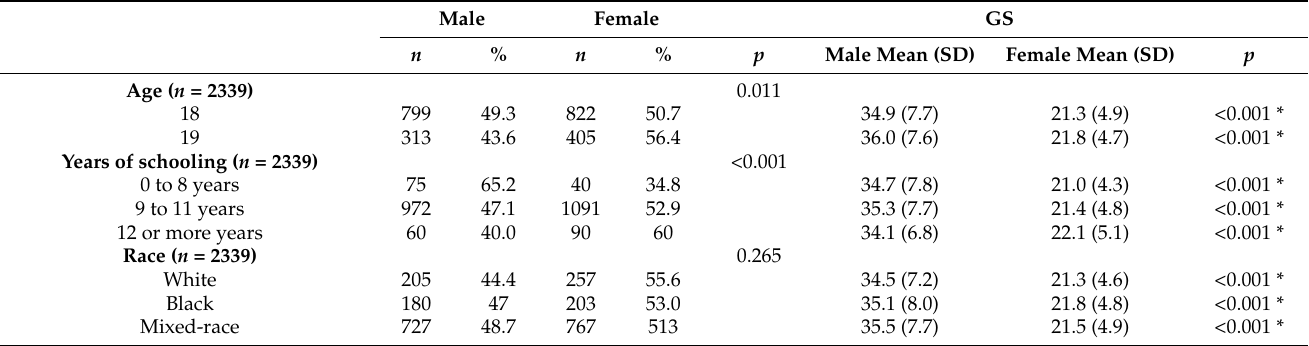
Table 1. Sample characterization according to demographic, socioeconomic, and lifestyle characteris- tics compared to sex and mean grip strength, by sex, for all variables. S ã o Lu í s, Maranh ã o, Brazil,